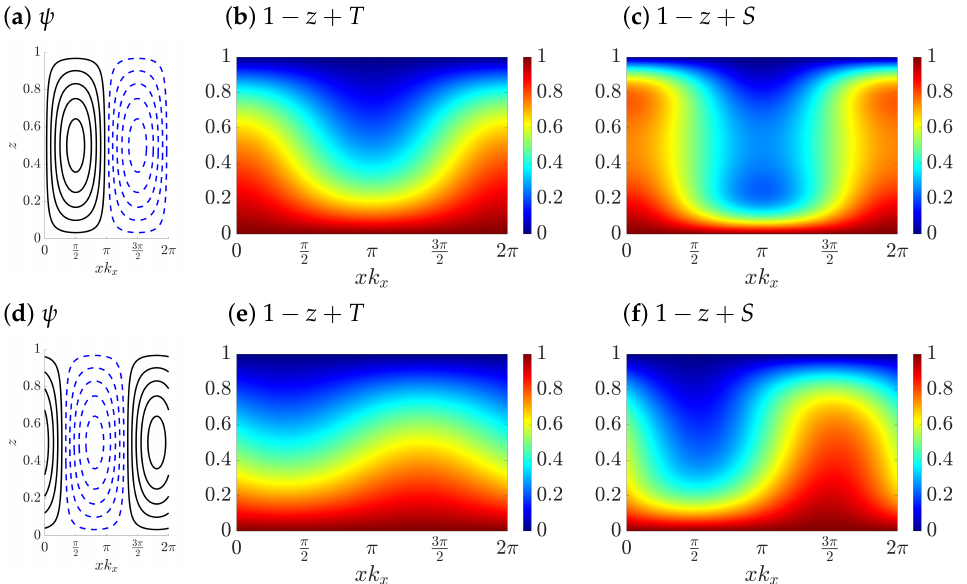
Figure 10. Top: solution profiles for steady convection rolls from the single-mode equations at Ra T = 55 with isocontours of ( a ) streamfunction ψ , ( b ) total temperature 1 − z + T and ( c ) total salinity 1 − z + S . Bottom: solution profiles for a left traveling wave with c = − 1.07 in the comoving frame from the single-mode equations at Ra T = 53 with isocontours of ( d ) streamfunction ψ , ( e ) total temperature 1 − z + T and ( f ) total salinity 1 − z + S . Other parameters are R ρ = 0.1, Le = 5, k x = π and k y = 0 as used in 2D DNS with periodic B.C. in the horizontal and period L x = 2 π / k x = 2 (Figure 8 in